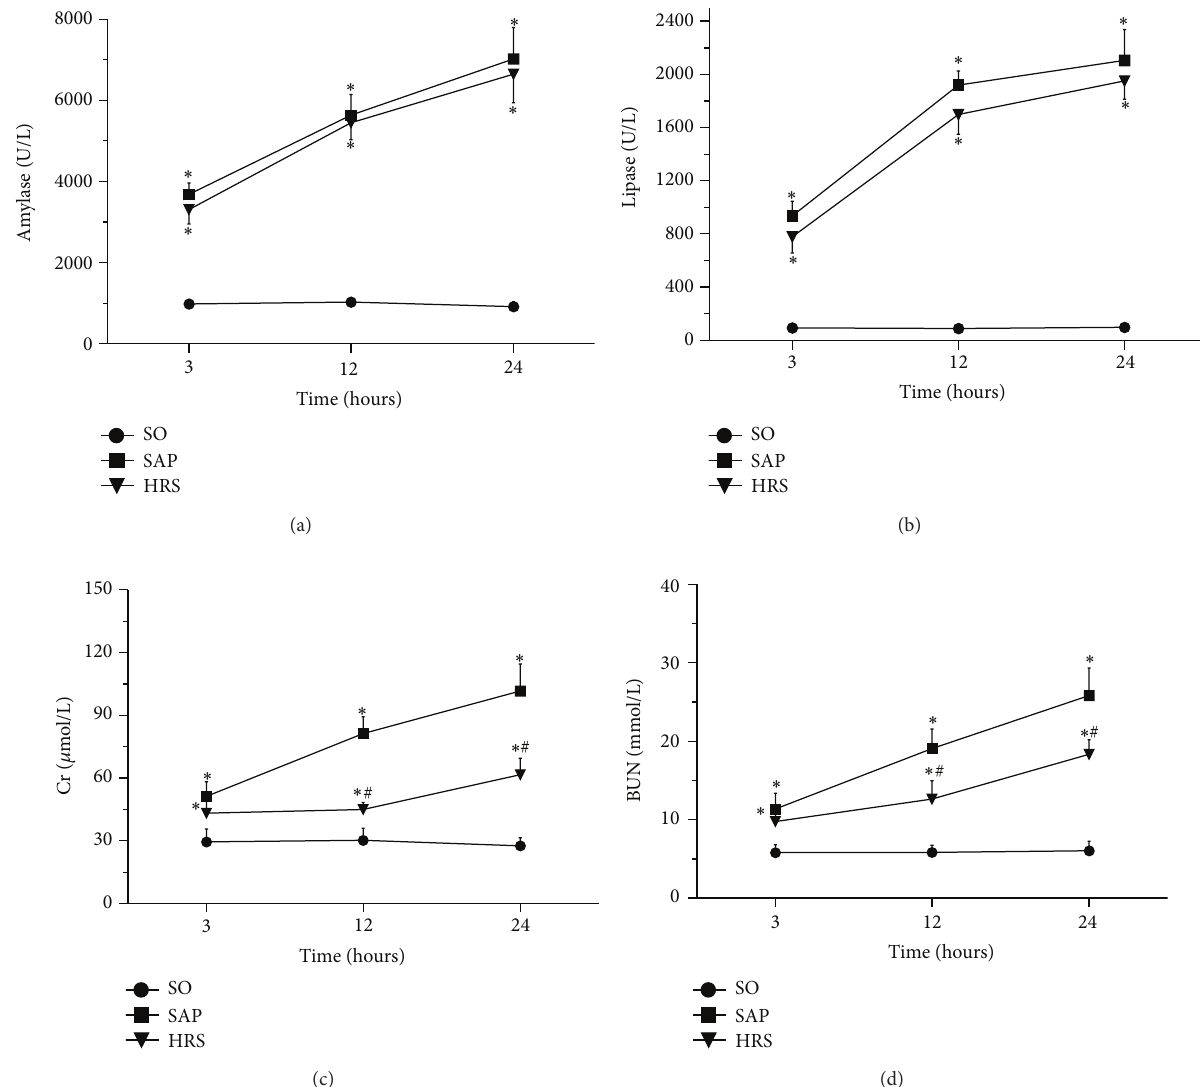
Figure 1: Serum levels of AMY, LIP, Cr, and BUN in all groups of rats. (a) Serum AMY level, (b) serum LIP level, (c) serum Cr level, and (d) serum BUN level. Results are expressed as mean (SD), 8 rats per group. ∗ 𝑃 < 0.05 versus respective SO group; # 𝑃 < 0.05 versus respective SAP